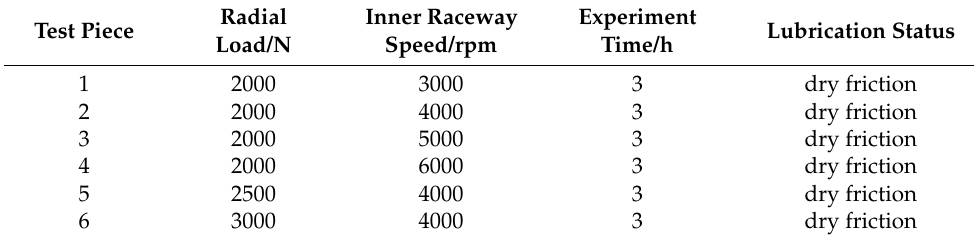
Figure 7. Experimental equipment.